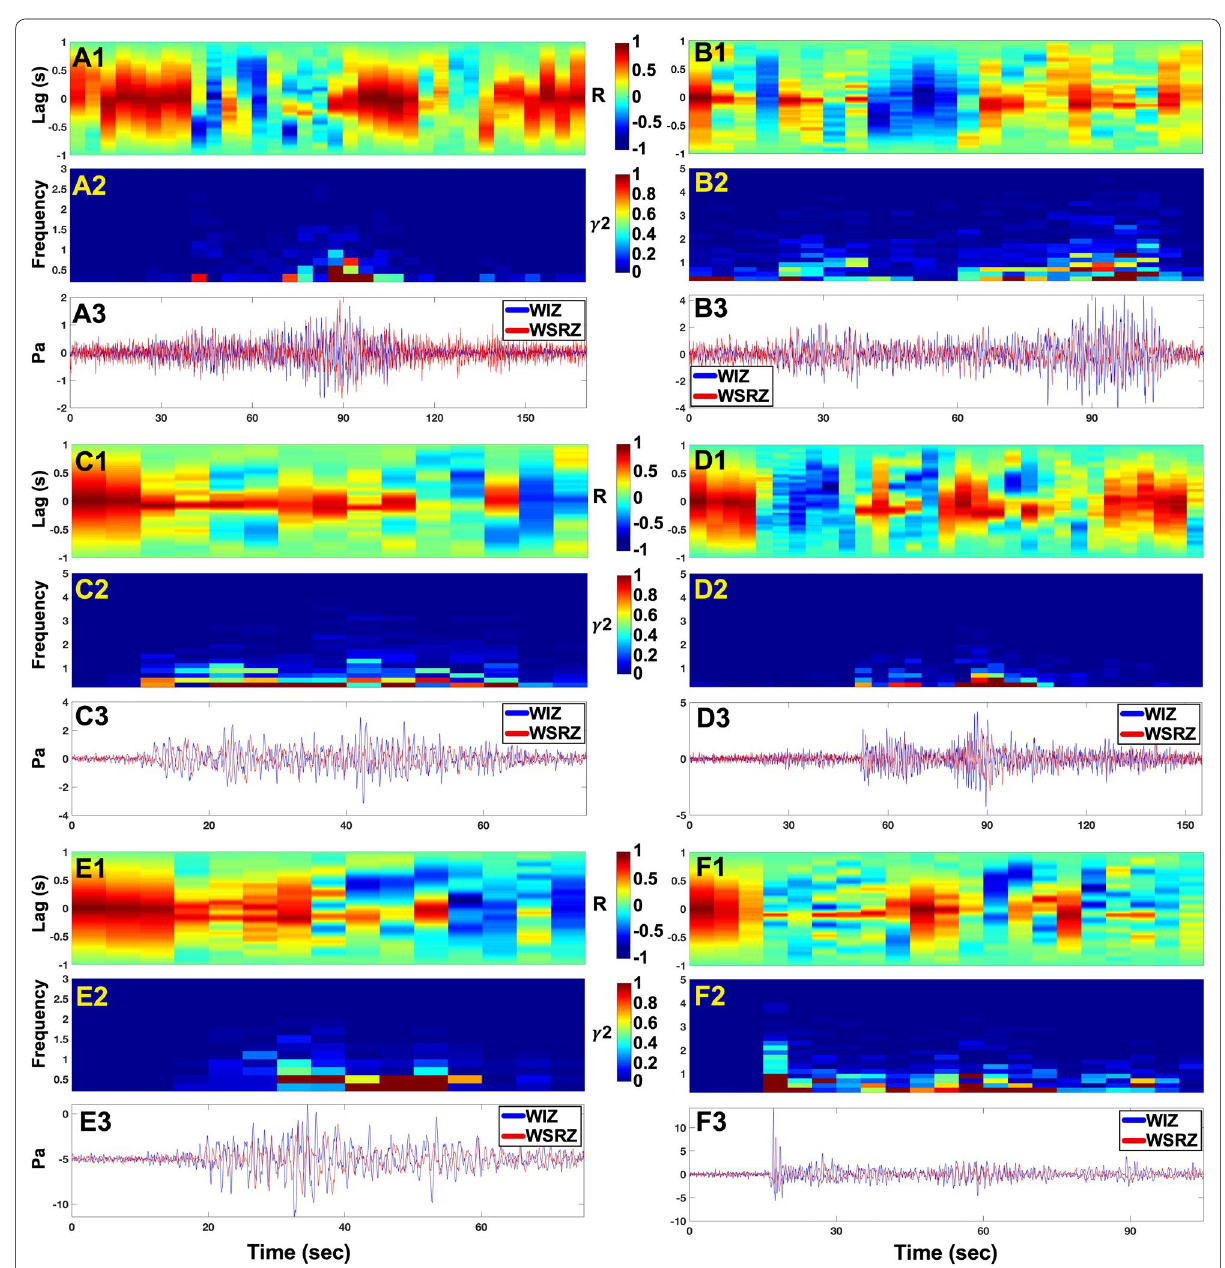
Fig. 10 Acoustic time evolution comparing station WIZ with WSRZ of the 27 April 2016 eruption pulses. A Pulse 1, B pulse 2, C pulse 3, D pulse 4, E pulse 5, F pulse 6. (1) Unfiltered cross-correlation, (2) unfiltered coherence, (3) acoustic signals WIZ and WSRZ overlain filtered between 0.5 and 10 Hz for each pulse. Subfigures labeled with 1 s and 2 s were estimated from 5-s moving time